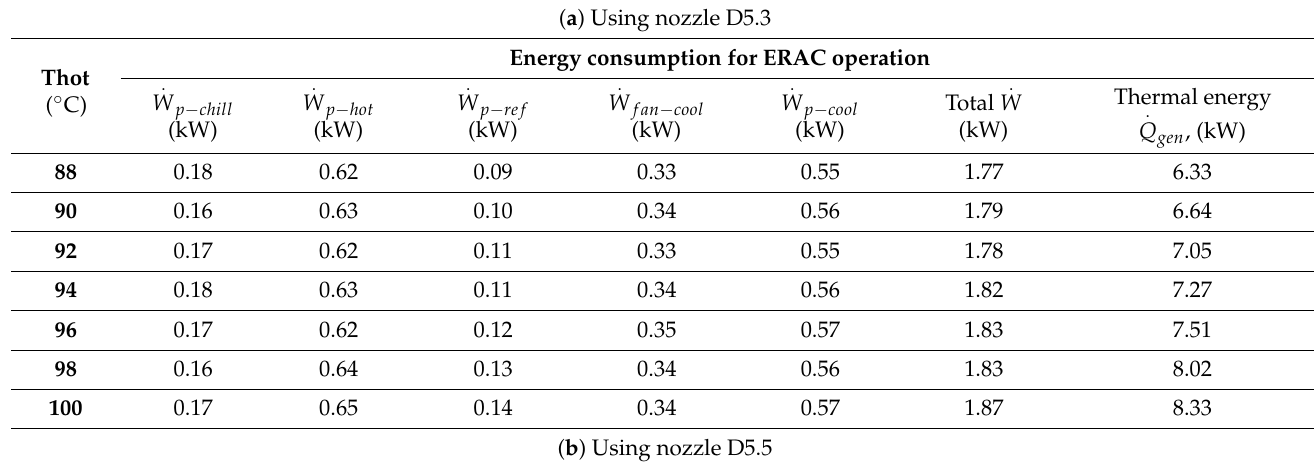
Table 1. Electricity and thermal energy consumption under various hot water